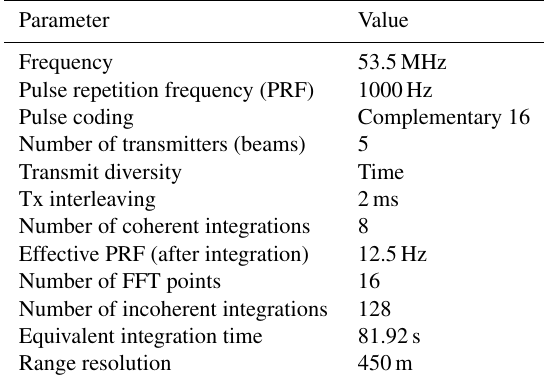
Table 1. Parameters of MAARSY MIMO